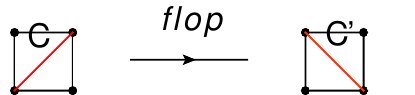
Figure 2 . Two different resolutions of a lattice polygon can be related by sequence of flops shown